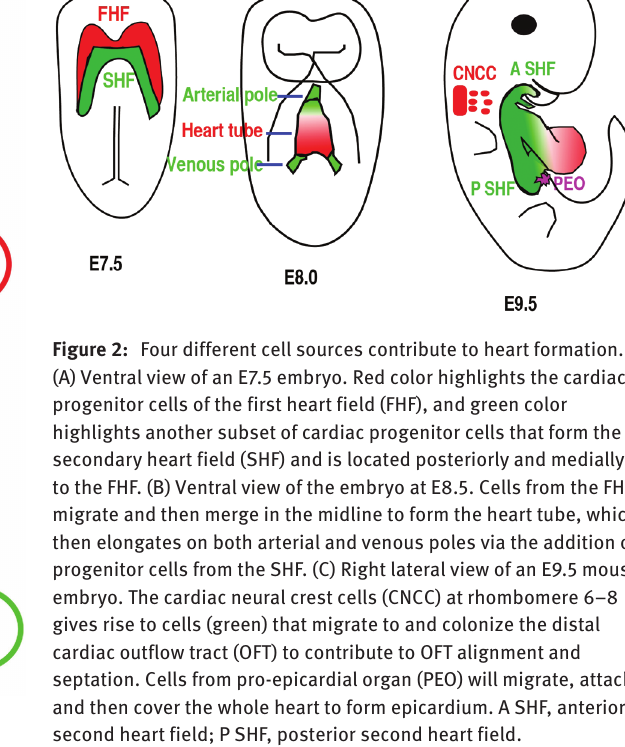
Figure 1: Numb is asymmetrically distributed during asymmetric cell division in different cell types.